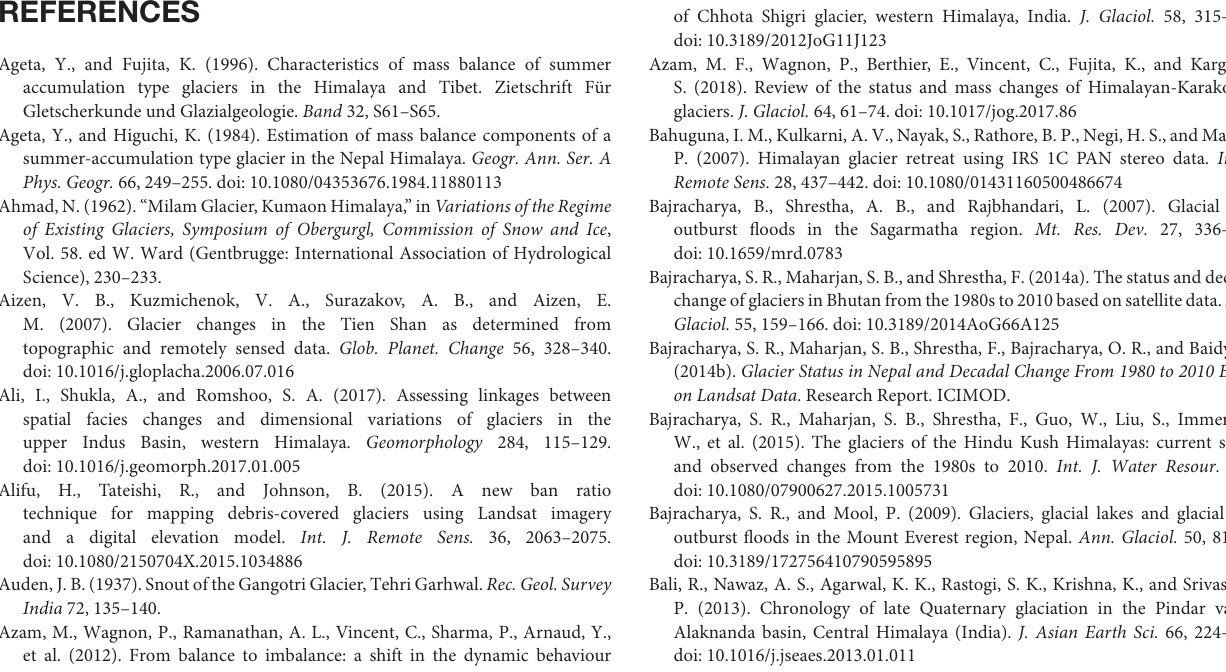
Figure S1 | Reduced width of Pacchmi Bamcchu glacier at the confluence with the Milam glacier. The width of the confluence was ∼ 253.5m in 1968 (A) , which decreased to ∼ 110m in 2017 (B) . Table S1 | Review of glaciological studies on the Milam